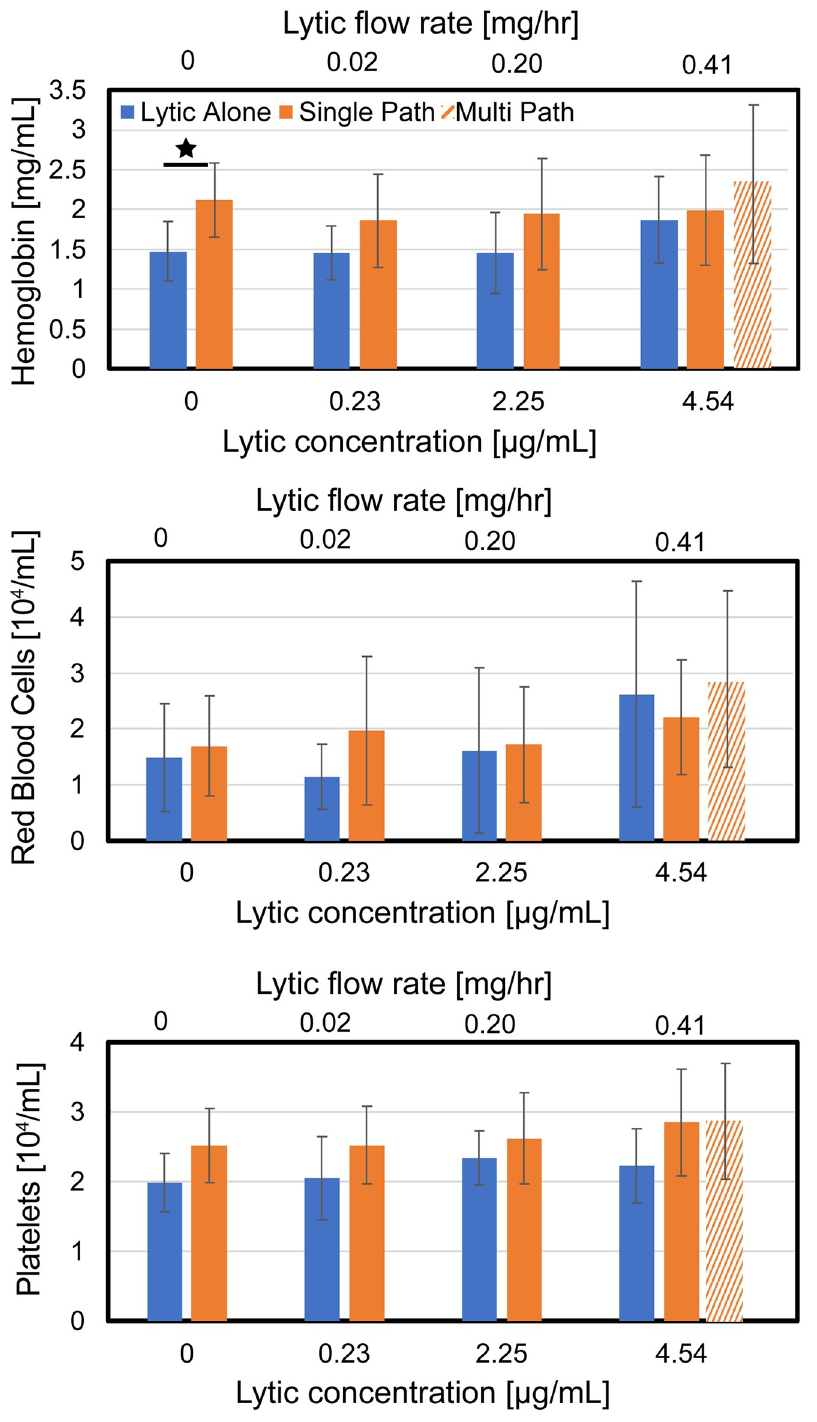
Fig 4. Analysis of cellular clot debris in the perfusate following treatment as a function of the lytic rt-PA concentration. (Top panel) Hemolysis, indicative of red blood cell lysis, (Middle panel) Intact red blood cells, and (Bottom panel) Intact platelets. Stars indicate a statistically significant difference (p < 0.05). The legend in the top panel indicates the insonation scheme, and is consistent for all panels. Histotripsy was not applied for the ‘Lytic Alone’